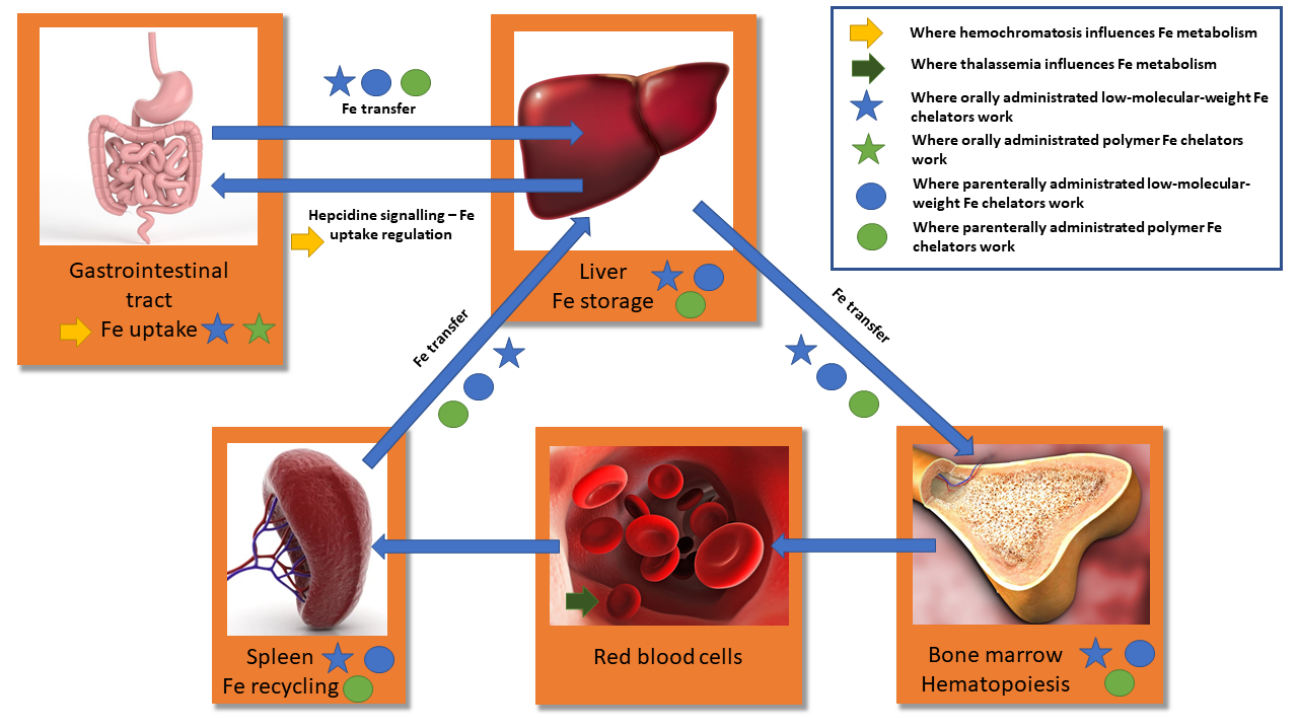
Figure 5. Simplified overview of iron metabolism and iron flow in organism shows where the overload occurs due to hemochromatosis and thalassemia and where the effect of both low-molecular-weight and polymer-drug effect takes place.